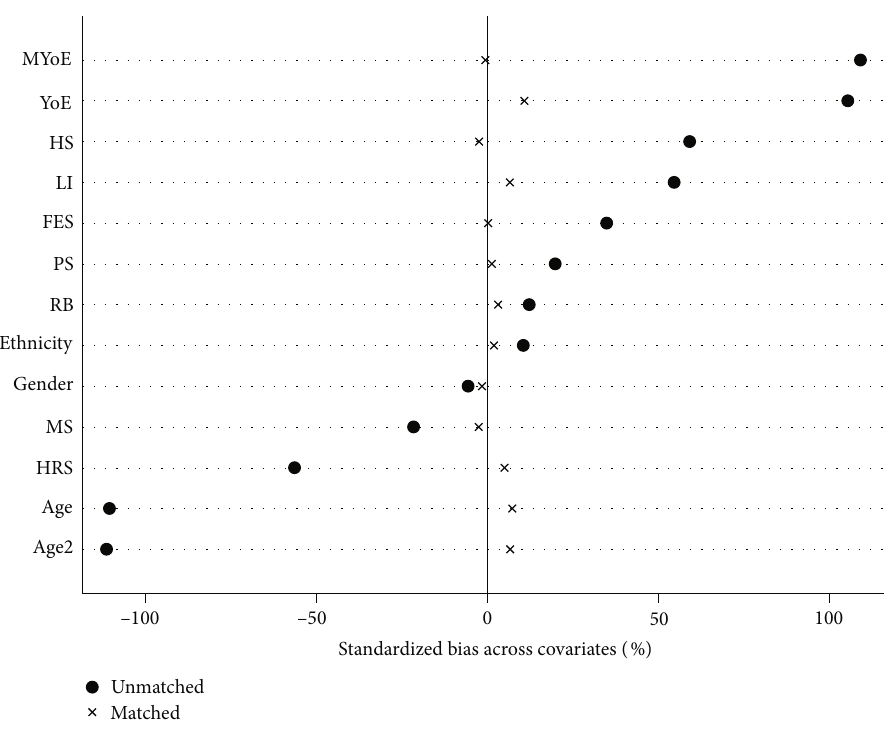
Figure 1: Changes in standardized percentage deviation of covariates before and after matching.